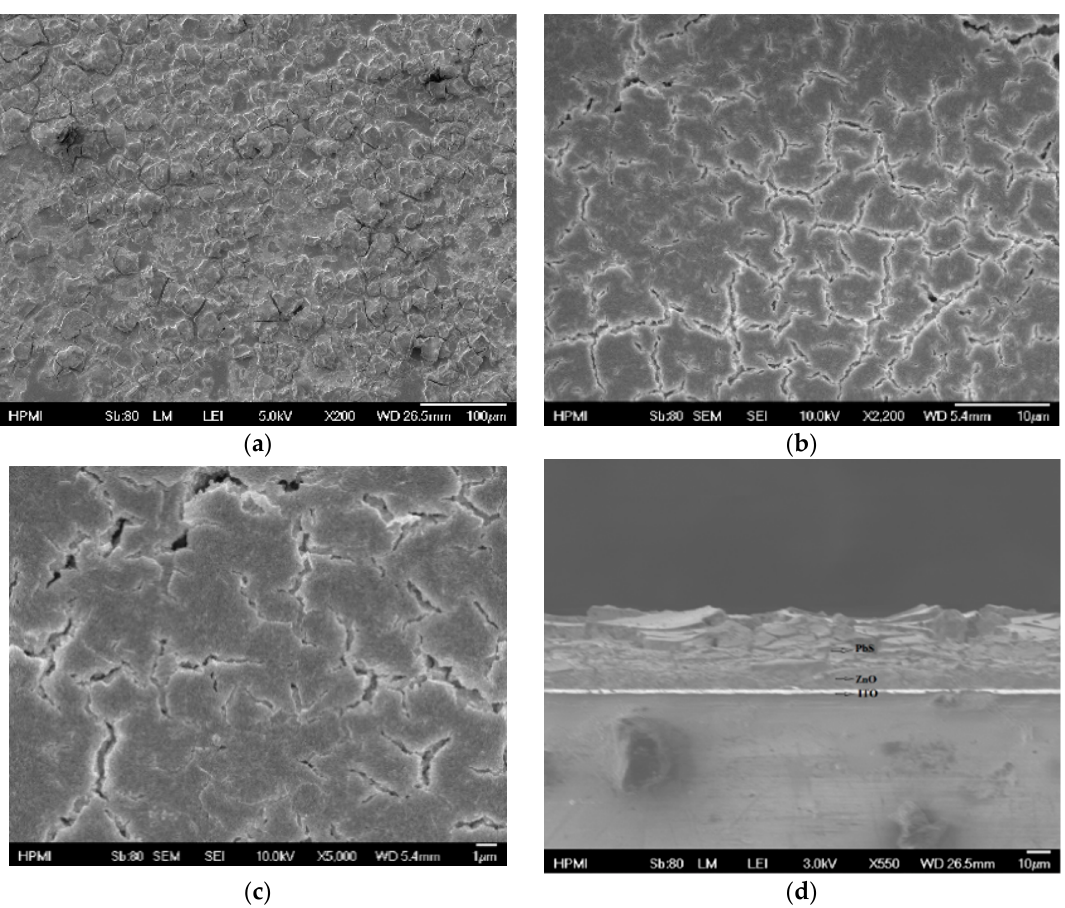
Figure 3. Field emission scanning electron microscope (FESEM) images of TBAI and EDT exchanged film with different magnifications: ( a ) 100 μ m; ( b ) 10 μ m; ( c ) 1 μ m. ( d ) Cross-sectional image of the sample made using the drop cast method.